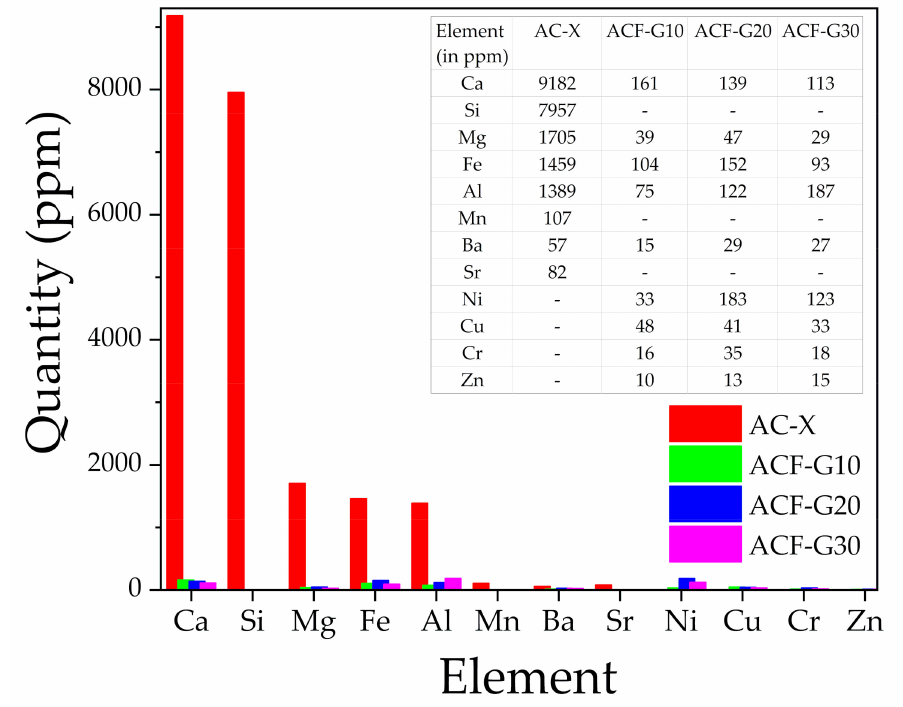
Figure 4. ICP-OES analysis results showing the content of metallic impurities (in ppm) in the